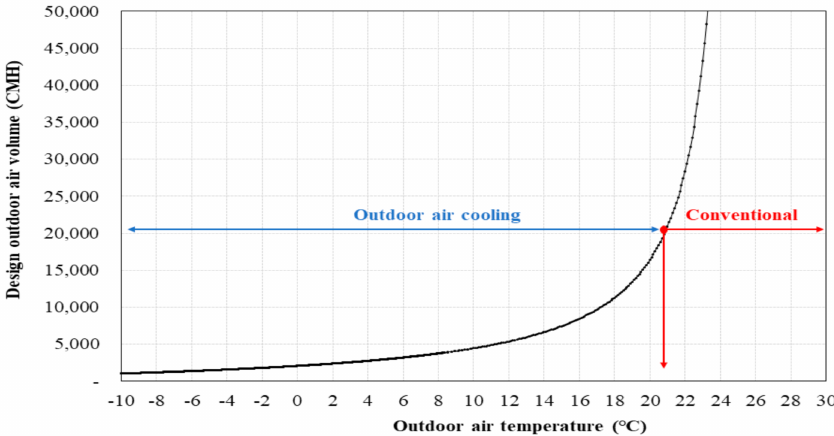
Figure 8. Variation in design air volume used for outdoor air cooling according to outdoor air